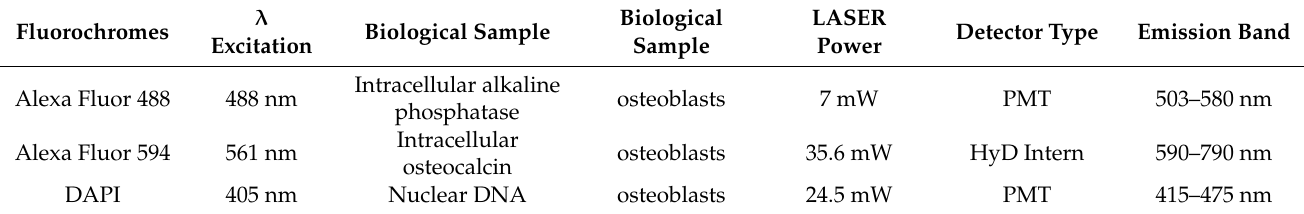
Table 1. Parameters used during acquisitions with confocal